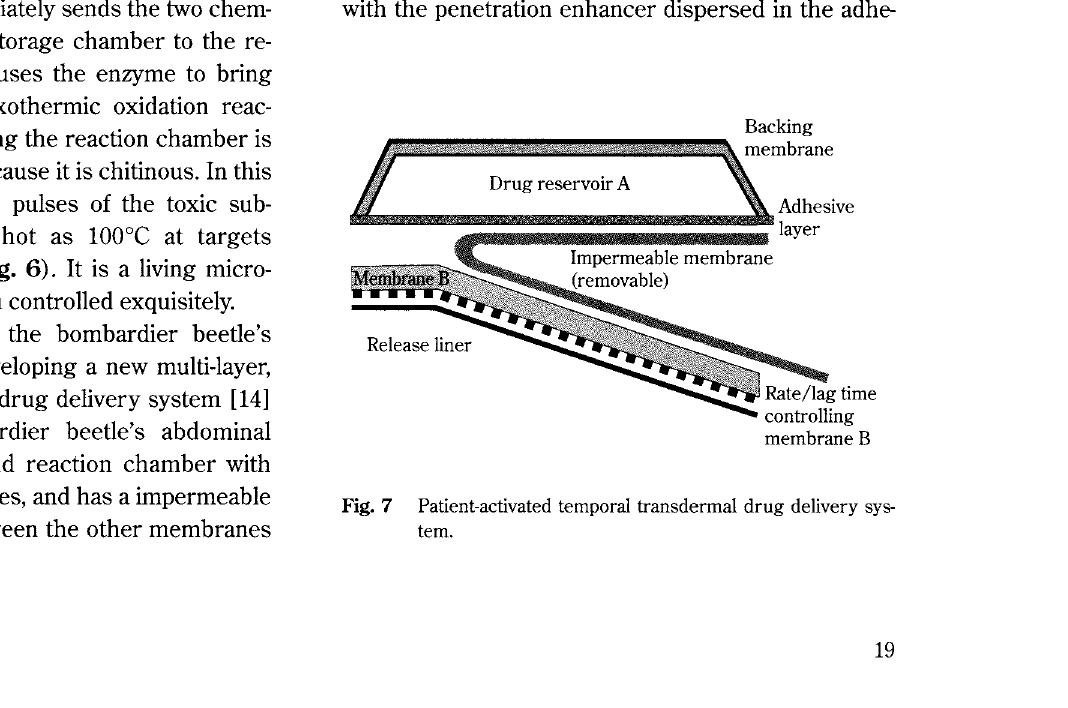
Patient-activated temporal transdermal drug delivery sys